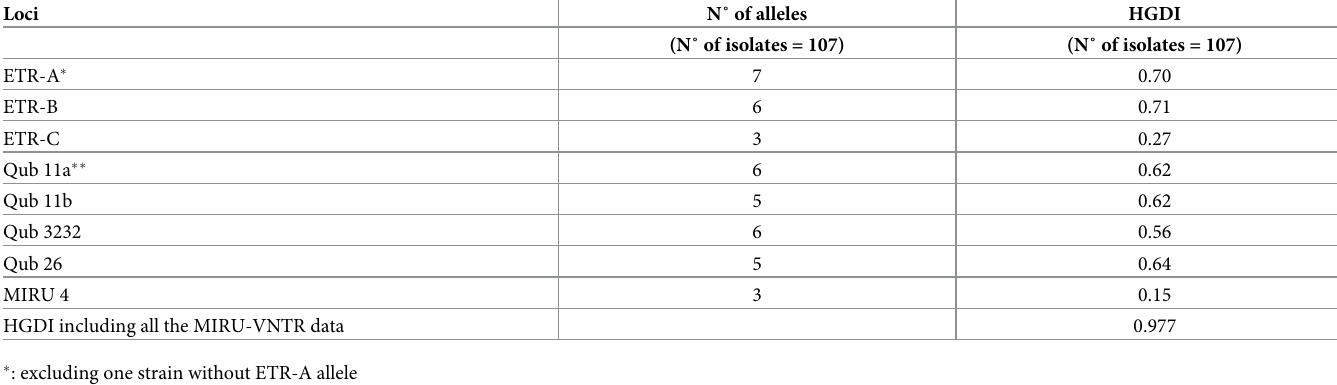
Table 2. Number of alleles and Hunter-Gaston discriminatory Index (HGDI) for the 8 MIRU-VNTR loci used in the study.